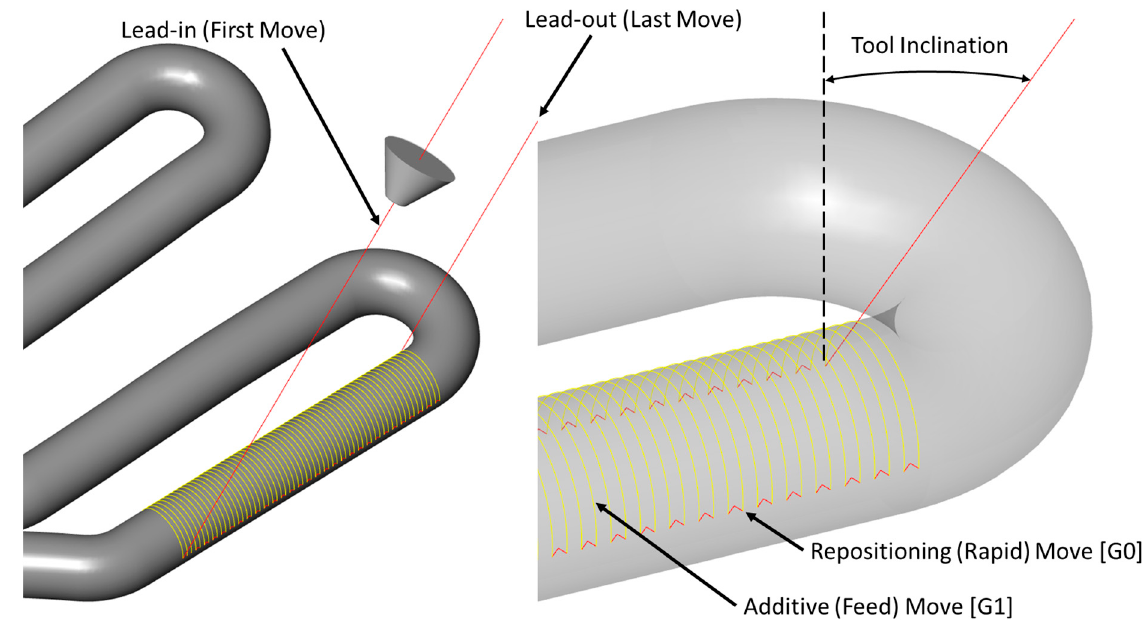
Figure 2. Linear cooling channel CAM strategy (refer to Video S2).